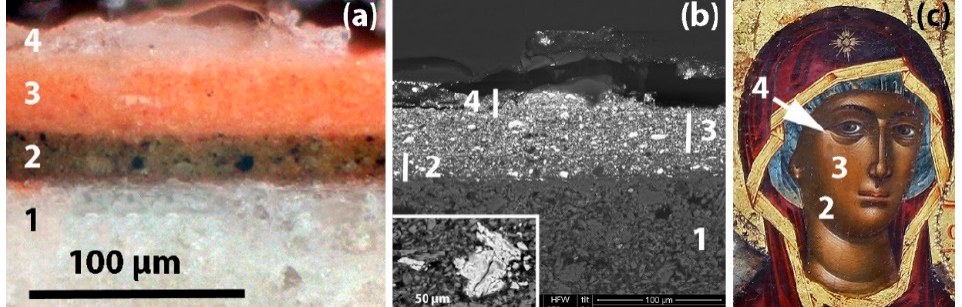
Figure 2. ( a ) Cross-section of a microsample; numbers mark the successive paint layers that lay on the ground (1); detail of an OM image (200 × ). ( b ) Same cross-section as seen through the SEM’s BSE detector (1000 × ). Note the extensive use of lead white grains (white particles) in all three flesh paint layers (2–4). ( c ) Detail of the Virgin Mary icon showing the flesh primary color (2), midtones (3) and highlights (4).